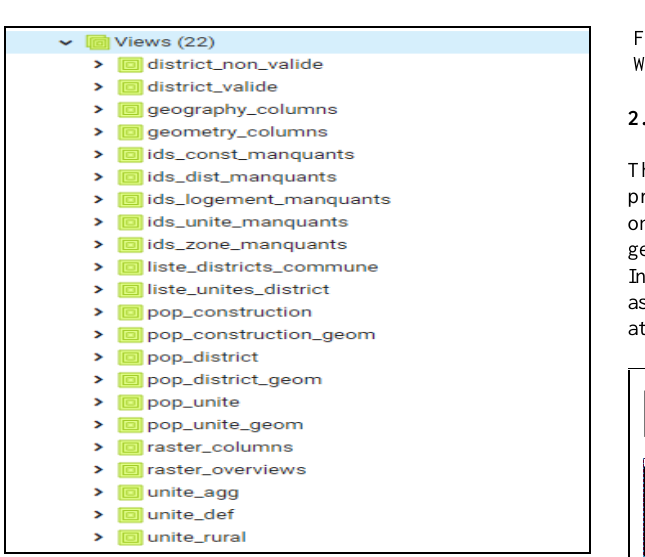
Figure 2. Implemented views.